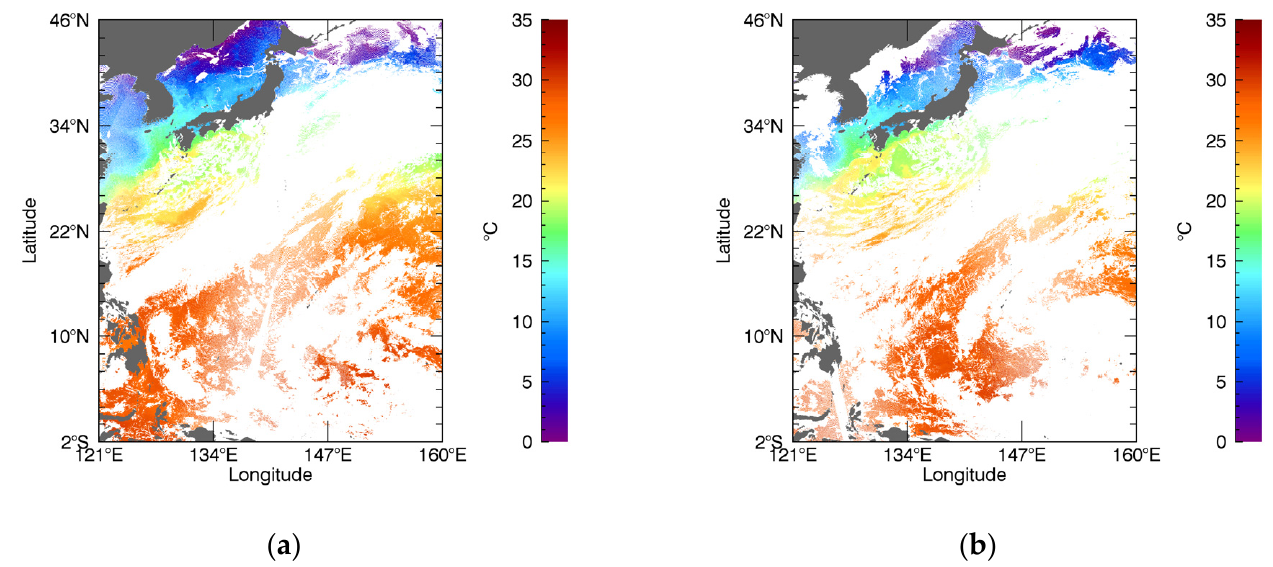
Figure 9. VIRR SST skin after projection in the daytime and nighttime on 28 March 2016: ( a ) daytime; ( b )